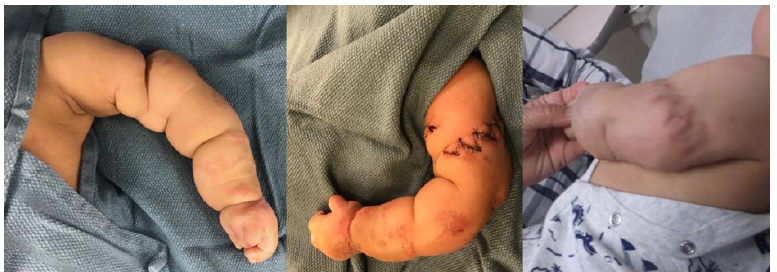
Figure 2. Clinical photos of Patient 1: preoperative, intraoperative, and 1-year postoperative (left to right).